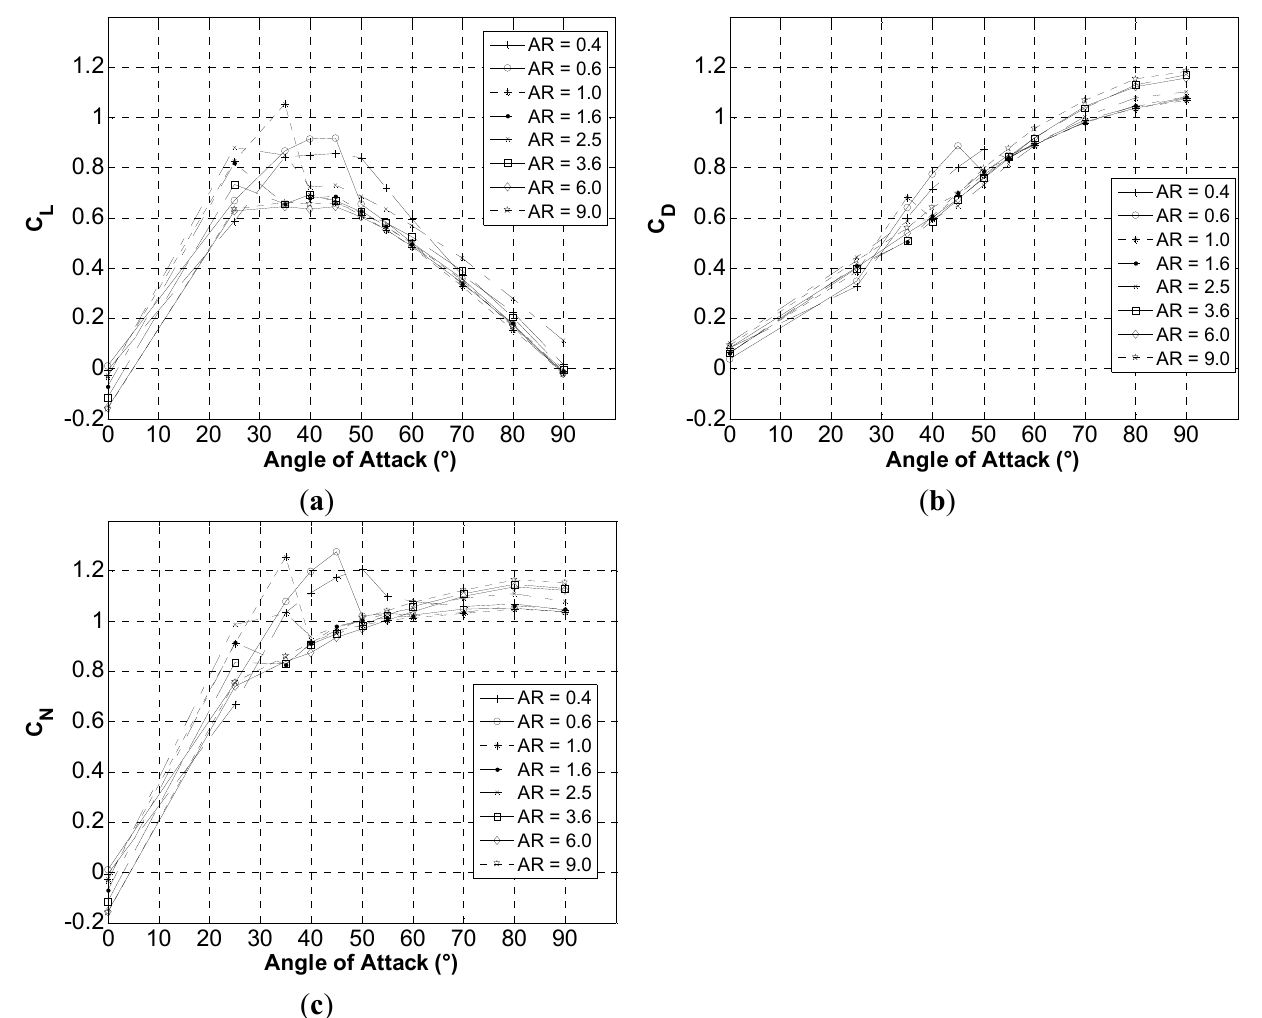
Figure 3. Measurements and correlations of the drag of normal flat plates as a function of aspect ratio.